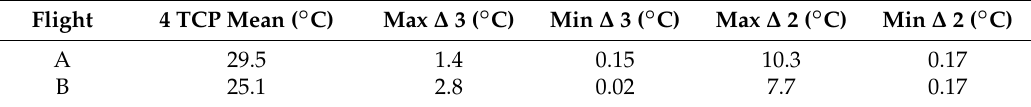
Table 3. Deviation of mean orthomosaic temperature from the original (‘4 TCP mean’) when calculated using three or two TCPs, respectively. Max 3(2) Δ = maximum difference in mean temperature between ‘4 TCP mean’ and mean calculated using 3(2) TCPs. Min 3(2) Δ = minimum difference in mean temperature between ‘4 TCP mean’ and the mean calculated using 3(2) TCPs. All numbers are absolute values. Flight